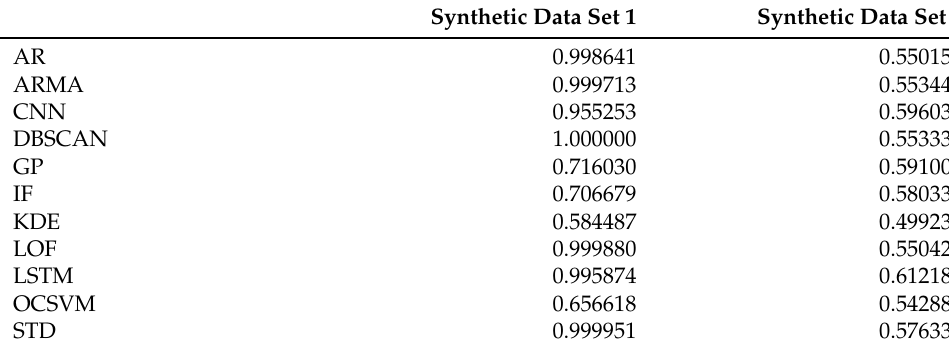
Table A3. Overview of the AUC values of the anomaly detection models.